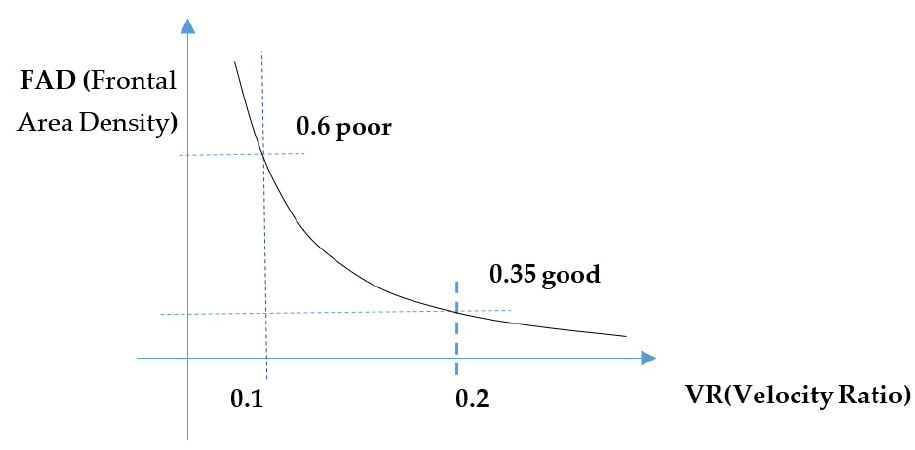
Figure 9. The relationship between frontal area density and velocity ratio [23].